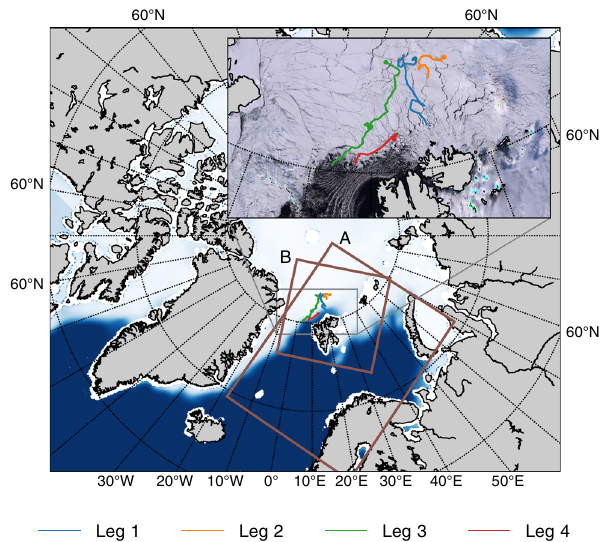
Fig. 1 General overview of the sea-ice cover, experimental model domains and N-ICE 2015 campaign drifts. Background: mean sea ice concentration in January – February 2015 according to OSI-SAF data; A: model domain for the AA (control) experiment, B: model domain for the AA-snow (sensitivity) experiment; coloured curves: trajectories of the different N-ICE 2015 campaign legs; inset: trajectories of N-ICE 2015 drifts and restored true colour image retrieved from MODIS radiances showing the ice cover on